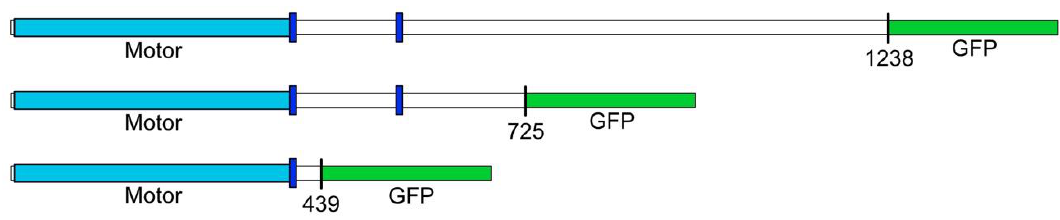
Figure 1. A schematic of the DdKif10 kinesin motor constructs. The position of the motor domain is indicated in light blue, and the dark blue boxes mark prominent coiled-coil motifs in the coding sequence. The top row represents the full-length, 1238aa construct. A detailed representation of the domain organization of DdKif10 can be found in reference [17]. Despite multiple attempts, we were only able to detect the expression of the middle-length construct in D. discoideum cells.